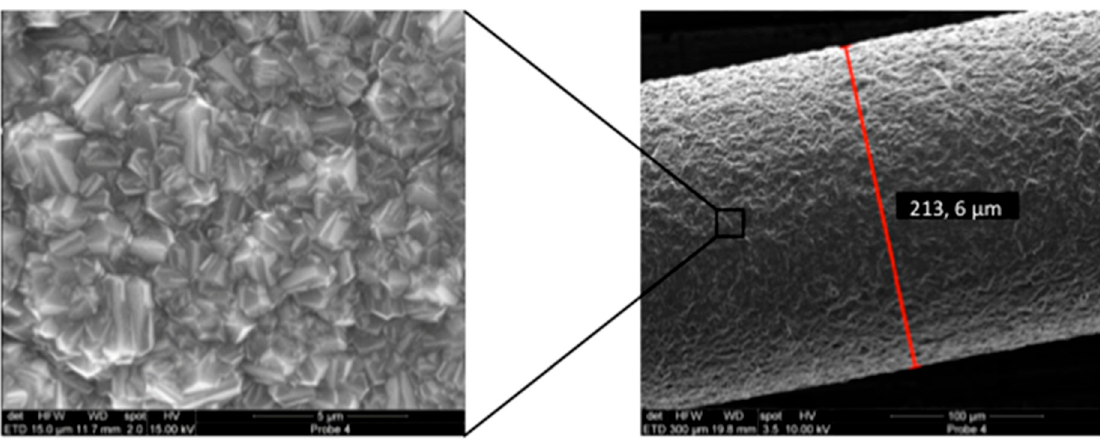
Figure 1. Scanning electron microscopy (SEM) image of a niobium wire after boron doped diamond (BDD) coating (Right: Overview; Left: Close up view of the area indicated by black rectangle). The coating layer has an approximate thickness of 2 µm and shows no delamination.